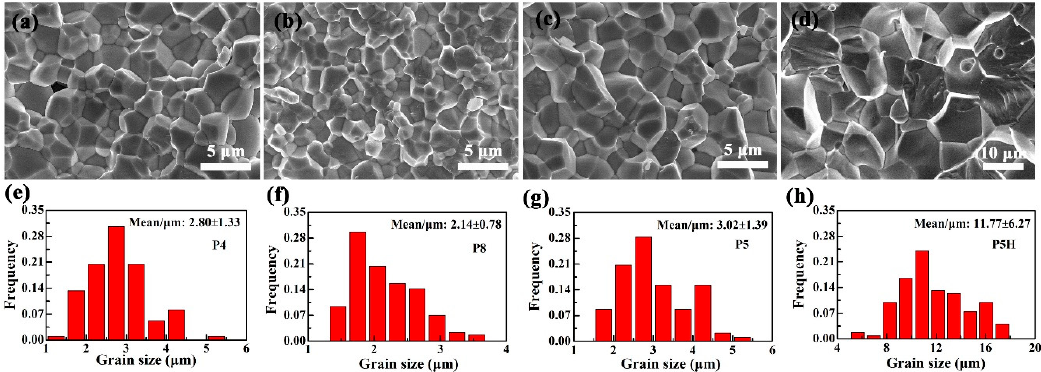
Figure 2. SEM micrographs and grain size distributions of the hard and soft PZT ceramics: ( a ), ( e ) P4; ( b ), ( f ) P8; ( c ), ( g ) P5; ( d ), ( h ) P5H.